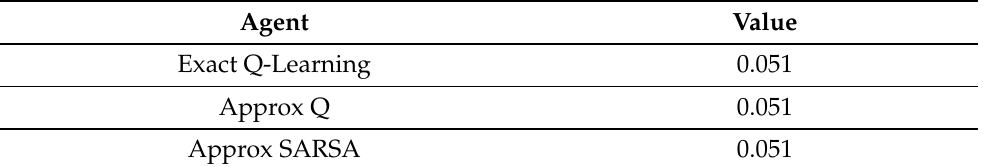
Table 6. (cid:101) -min (probability of minimum random moves).